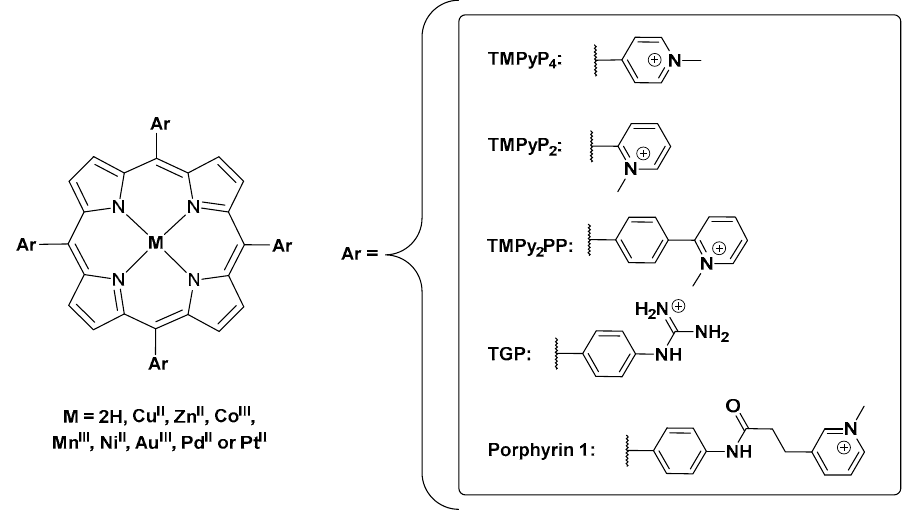
Figure 14. Structures of the porphyrins referred in Table 1.